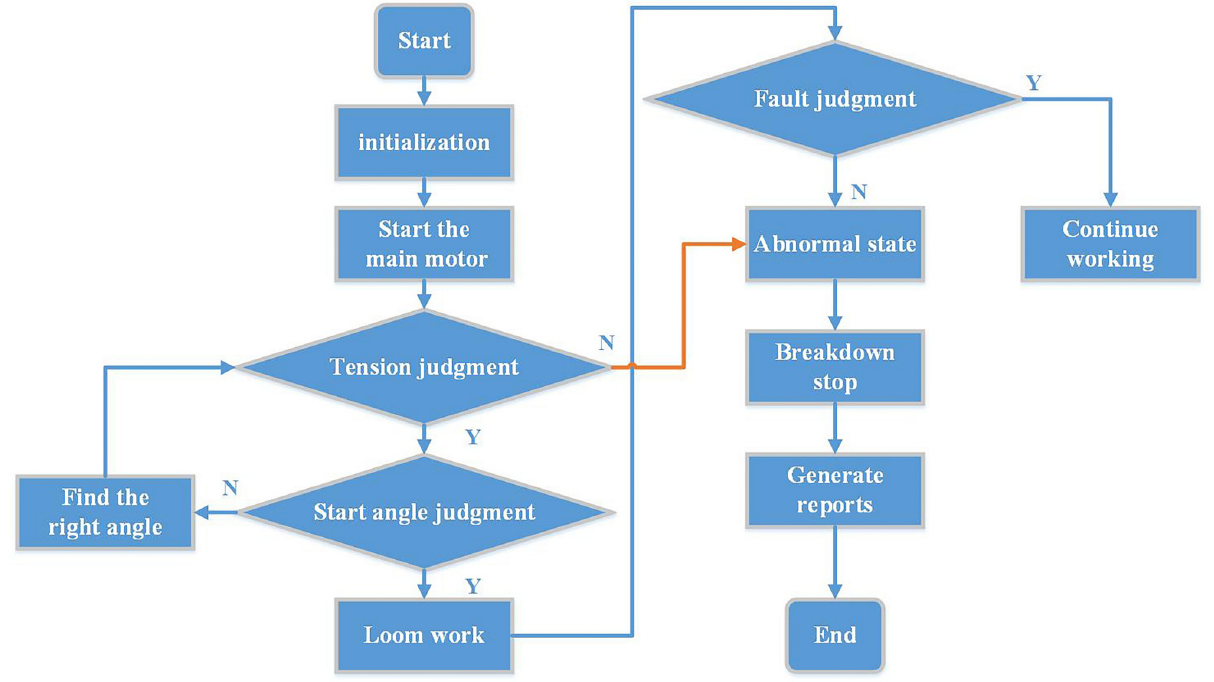
Fig 6. Overall design sketch of application